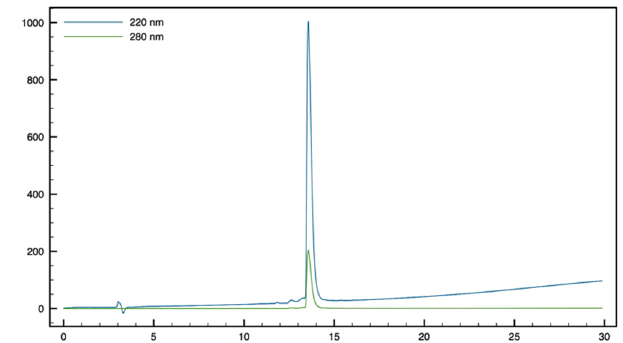
β 2,2 h bis-Arg-NHBn 21 .